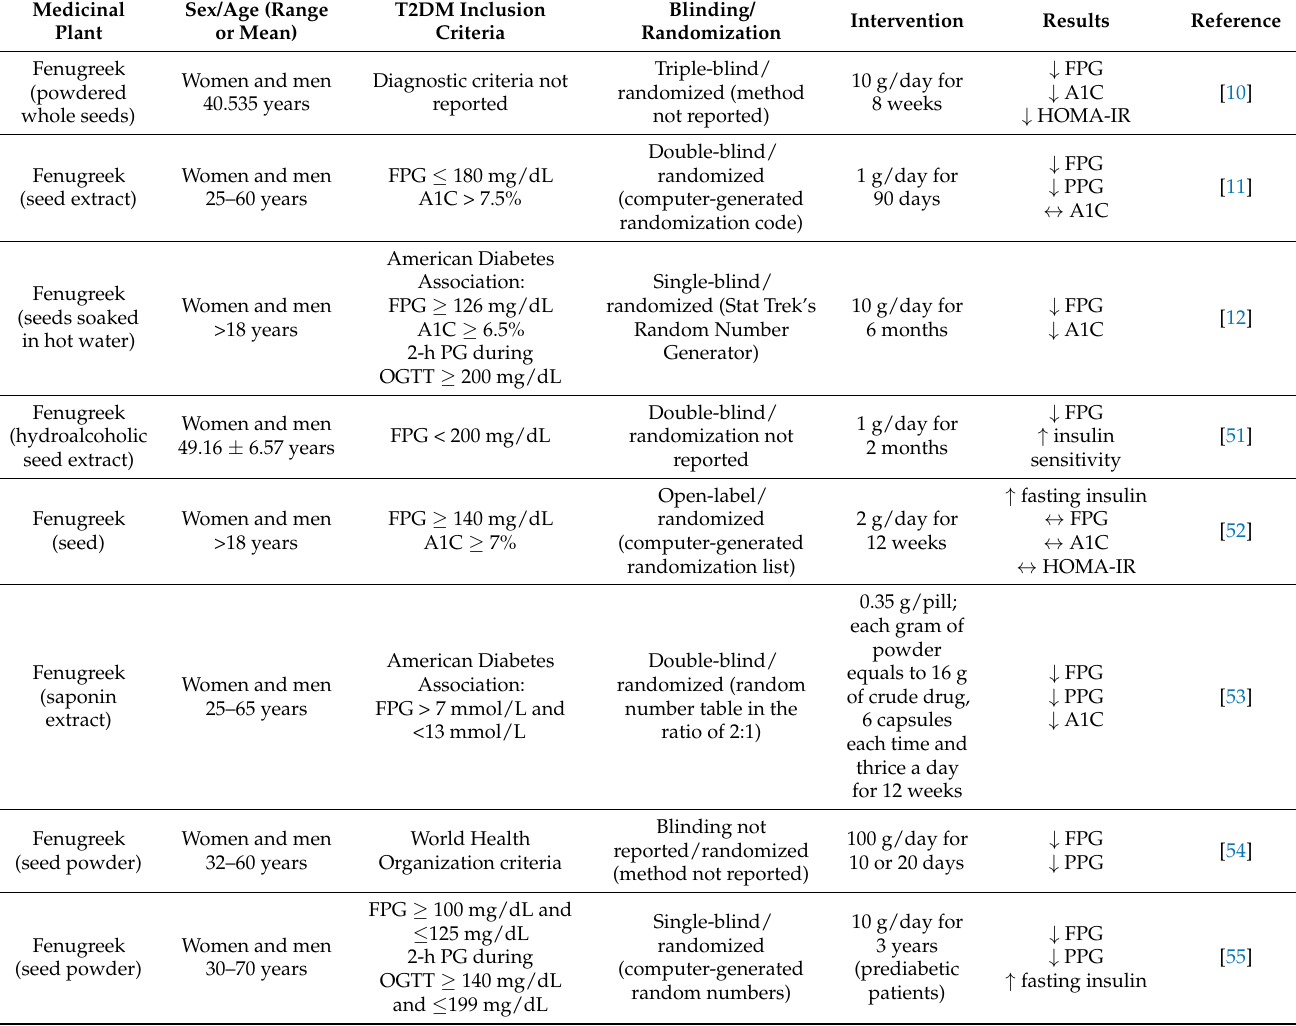
Table 1. Fenugreek: clinical evidence in type 2 diabetes